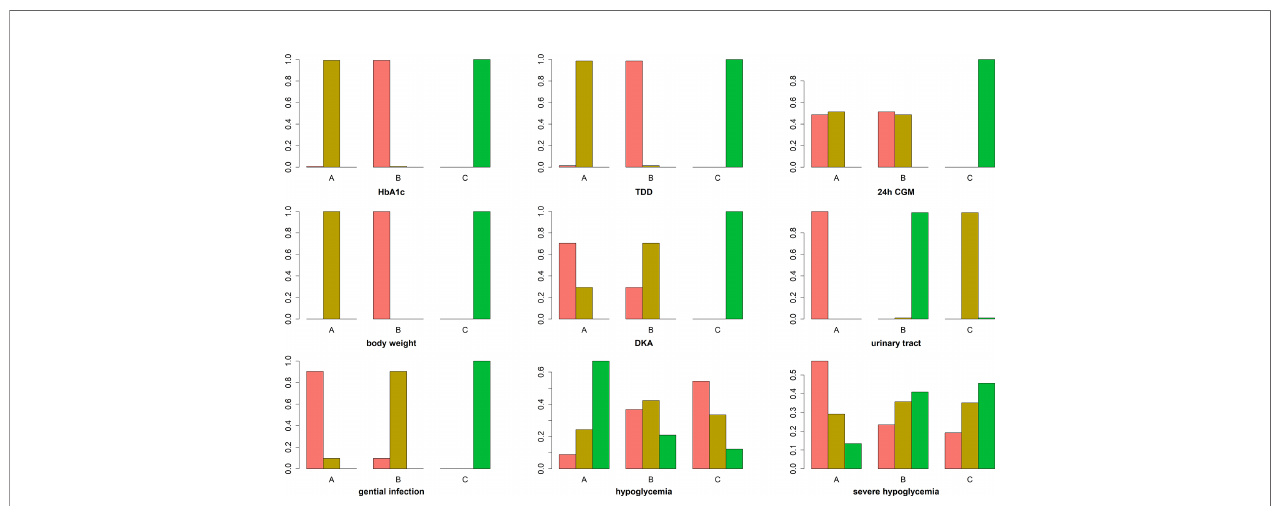
FIGURE 6 | Ranking chart of meta-analyses of different interventions and outcomes. The width of the lines presents the whole number of trials for every comparison, and the size of every node is proportional to the number of randomized participants (sample size). (A) dapagli fl ozin 5 mg + insulin, (B) dapagli fl ozin 10 mg + insulin, and (C) placebo +